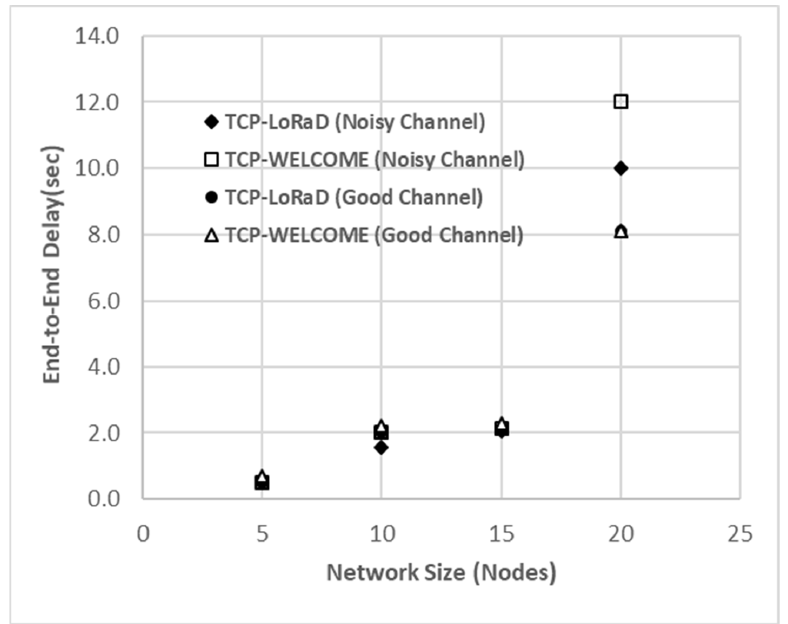
Figure 6. End-to-End delay versus increasing the number of nodes in a noisy channel. Comparison of TCP-LoRaD and TCP-WELCOME.